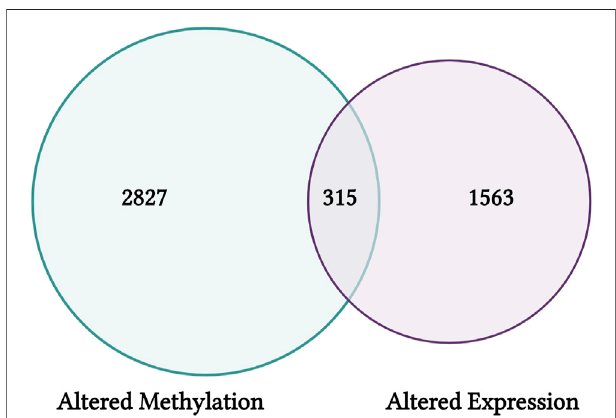
FIGURE 9 | CTD fi ndings from this training module highlight genes that haveshowndifferentialCpGmethylation(left)anddifferentialexpression(right) in association with arsenic exposure. Results are visualized here using an example Venn diagram, highlighting a group of 315 genes with altered expression that may be in fl uenced via epigenetic regulators through CpG methylation alterations.